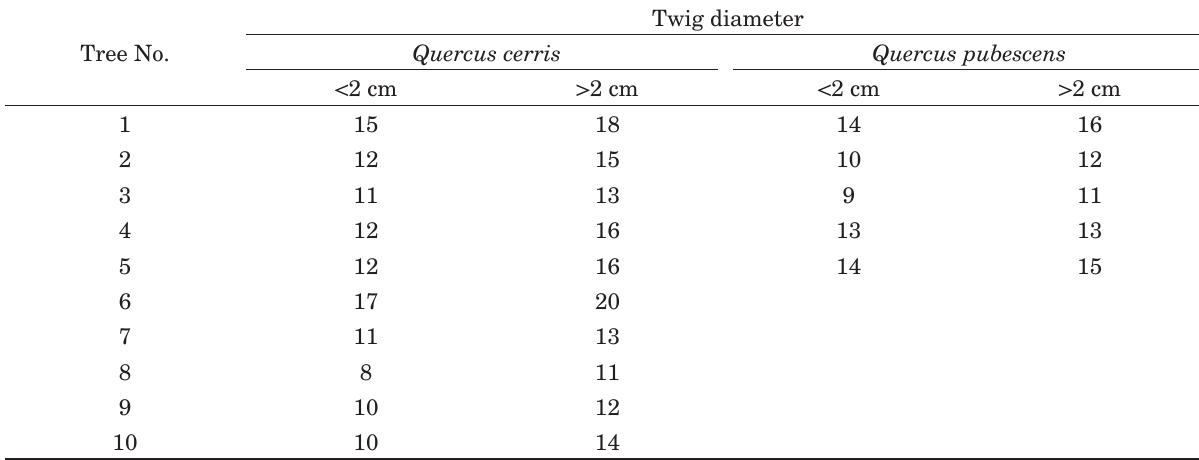
Table 1. Number of cankers on Quercus cerris and Quercus pubescens twigs from which Apiognomonia quercina was isolated .